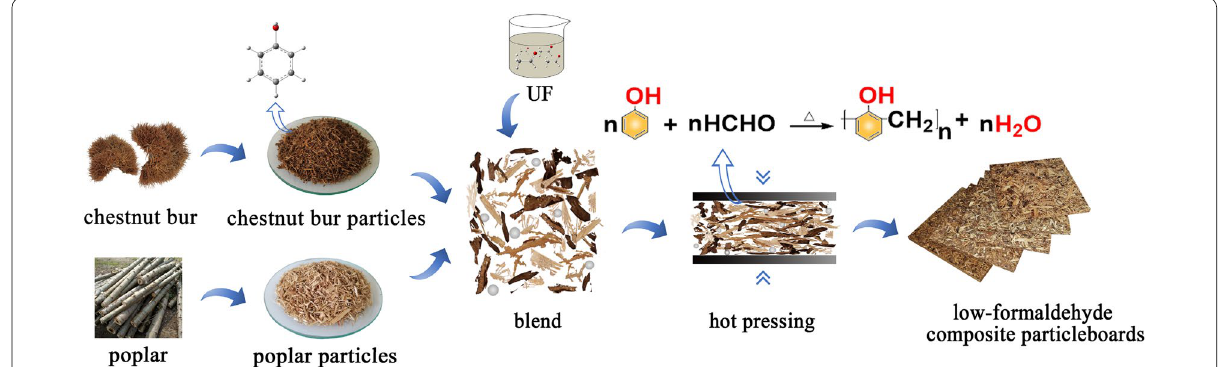
Fig. 2 Preparation route of bio-based low-formaldehyde composite